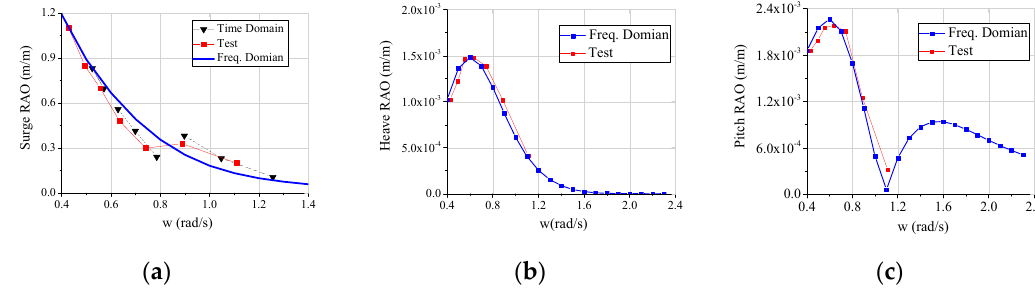
Figure 6. Dynamic responses analysis of the Serbuoys-TLP system under typical regular wave test conditions. ( a ) Surge; ( b ) Heave; ( c ) Pitch.